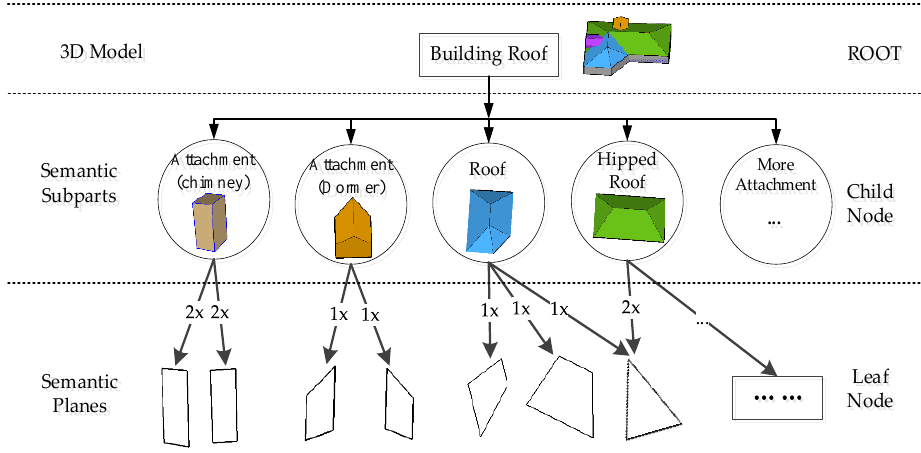
Figure 2. The hierarchical tree representation of a building.